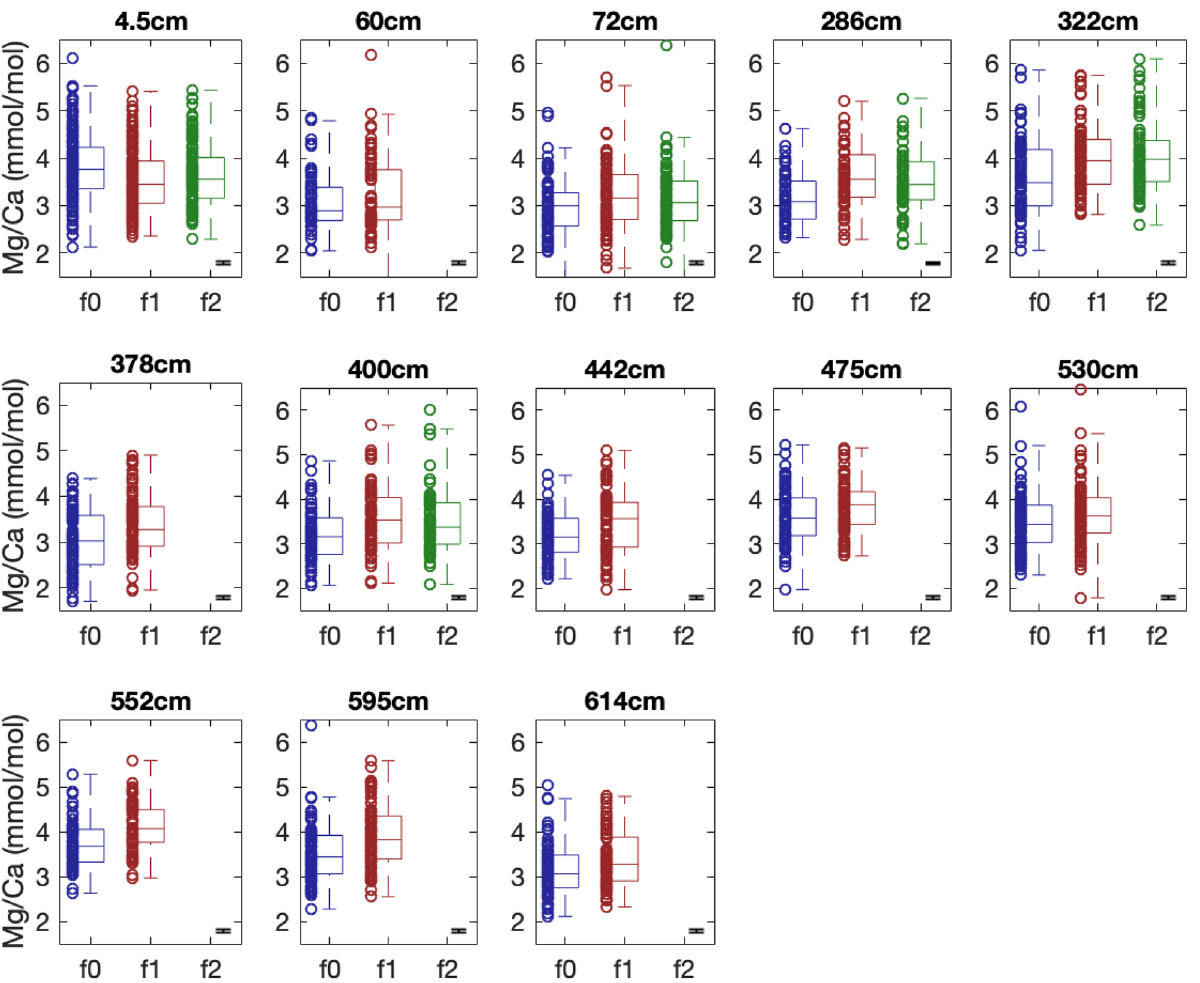
Figure 2. Single specimen Mg/Ca values for each chamber from various sample depths. Each circle is the mean of all laser-ablation ICP-MS (LA-ICPMS) Mg/Ca measurements on one chamber from a single specimen. The error bar at the right of each plot shows the mean analytical uncertainty (the standard error of the mean of individual laser ablation measurements on a given chamber) from that interval. Boxes show the interquartile range between the 25th and 75th quantiles; the line in the middle depicts the population median. Dashed vertical whiskers show the range. In all intervals except 4.5 cm, the f0 chamber mean is either the same or lower than the f1 mean. In the 4.5 cm interval, the f0 chamber mean is significantly higher than the f1 or f1 chamber mean. No significant differences were found between f1 and f2 chamber To fully assess the impact of this intra-test heterogeneity at the individual level, we compared the LA-ICPMS data to Mg/Ca measured on the same shells after chemical cleaning and analysis via ICP-OES. We analyzed 32 individuals from the 14MC-1 4.5 cm sample which have data from the f0, f1 and f2 chambers interval using ICP-OES. Mg/Ca data from ICP-OES is a single, integrated value for the entire shell, excepting the ablated mate- rial and any material lost during cleaning, and thus our data enable us to test whether differences in chamber composition significantly impact population metrics and distributions. We find that Mg/Ca values measured on the same individual using LA-ICPMS and ICP-OES correspond at both the population and individual levels. The population mean of our ICP-OES Mg/Ca data (3.55 mmol/mol ± 0.10) does not differ significantly from the population mean of the LA-ICPMS data from the f0 (3.71 ± 0.13), f1 (3.49 ± 0.11) and f2 (3.53 ± 0.10) chambers (Student’s t-test, p < 0.05, n = 32) (Fig. 6a). We also find no difference in the variance of ICP-OES Mg/Ca data (Fig. 6b) compared to the f0, f1, and f2 chambers (one-sided f-test, p > 0.05), and nonparametric testing indicates the populations are likely drawn from the same distribution (Kruskall–Wallis test, p > 0.05). We next used Q-Q analysis to test the similarity of Mg/Ca distributions from ICP-OES and LA-ICPMS, as shown in Fig. 7. We find that the Mg/Ca distribution from ICP-OES is the same as that from LA-ICPMS of the f0, f1 and f2 chambers. At the population level, we conclude that the ICP-OES and LA-ICPMS Mg/Ca populations are statistically identical. We now investigate the relationship between paired ICP-OES and LA-ICPMS Mg/Ca at the individual level by directly comparing Mg/Ca values from each individual, as shown in Fig. 8. The correlation coefficients (R) for the individual chamber LA-ICPMS Mg/Ca values and ICP-OES Mg/Ca are 0.83 (f0), 0.75 (f1), and 0.76 (f2) (p < 0.05 for all relationships). Given the similarity of the population distributions, such correspondence is not